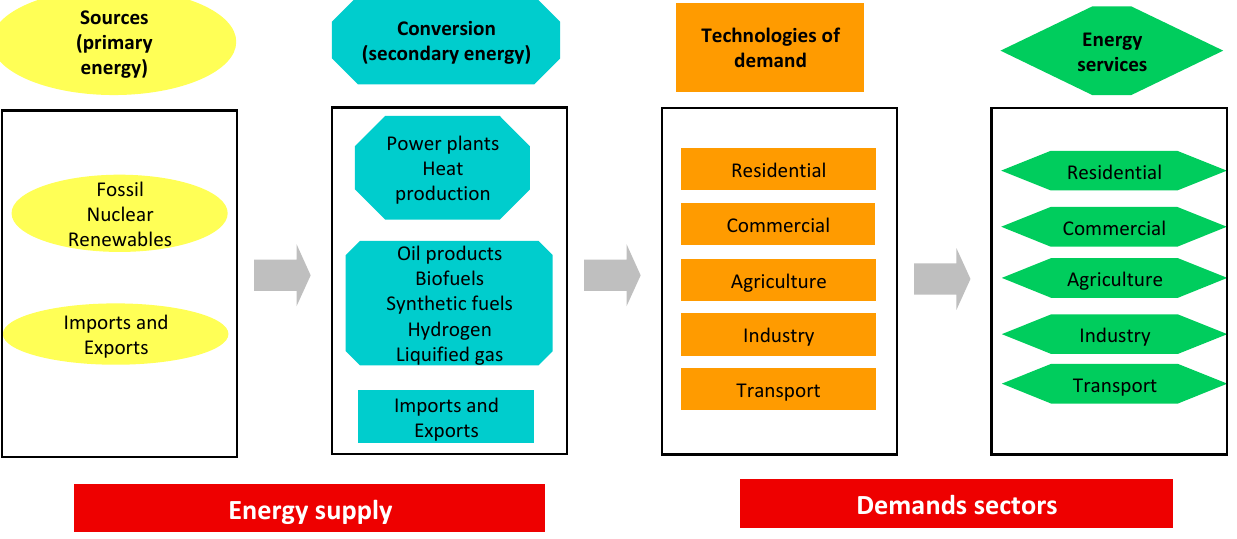
Figure 1. ETEM Reference Energy System.